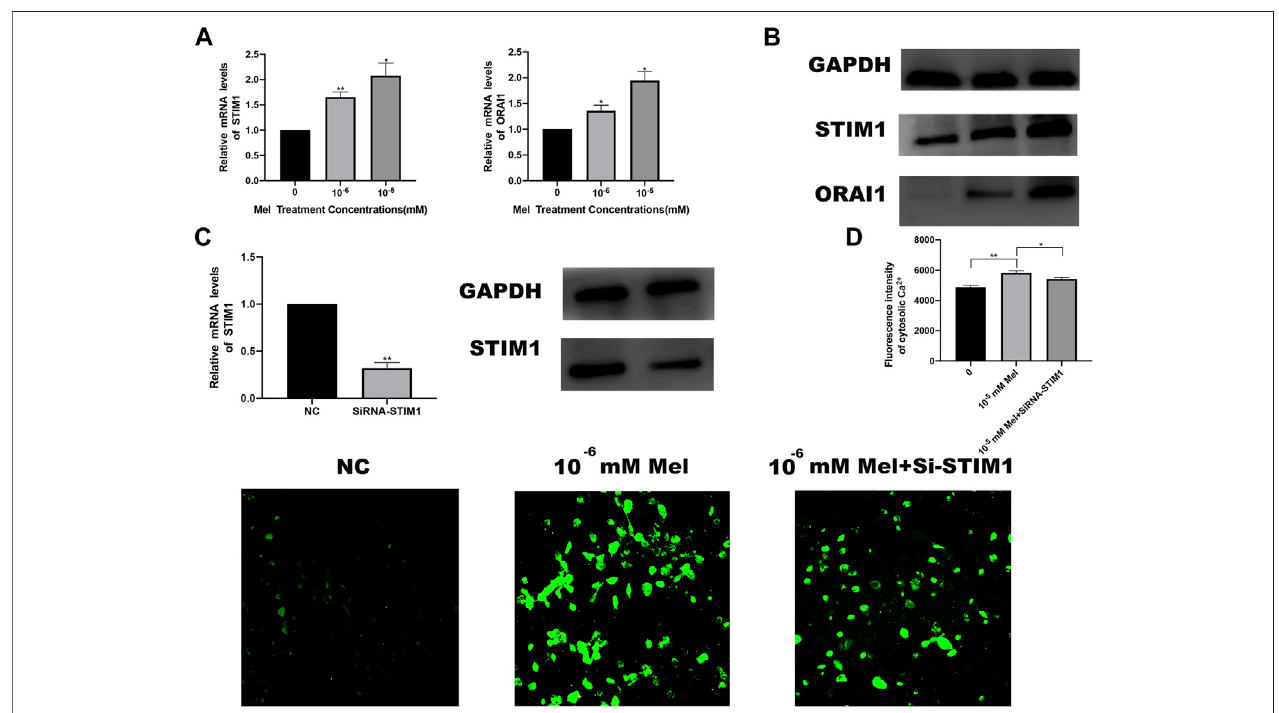
FIGURE 4 | Melatonin induces osteoblast proliferation through the STIM1/ORAI1 pathway. (A) The expression of the SOCE-related genes STIM1 and ORAI1 was detectedusing PCR. (B) Levels oftheSTIM1and ORAI1 proteins were detected using Westernblotting. (C) Transfection ef fi ciencyofthe STIM1siRNA wasdetermined bymeasuring mRNAand proteinlevels. (D) Fluorescence imagingand quali fi cationofCa 2+ levels usingtheindicatordye Fluo-4AMfollowingSTIM1-siRNAtransfection.